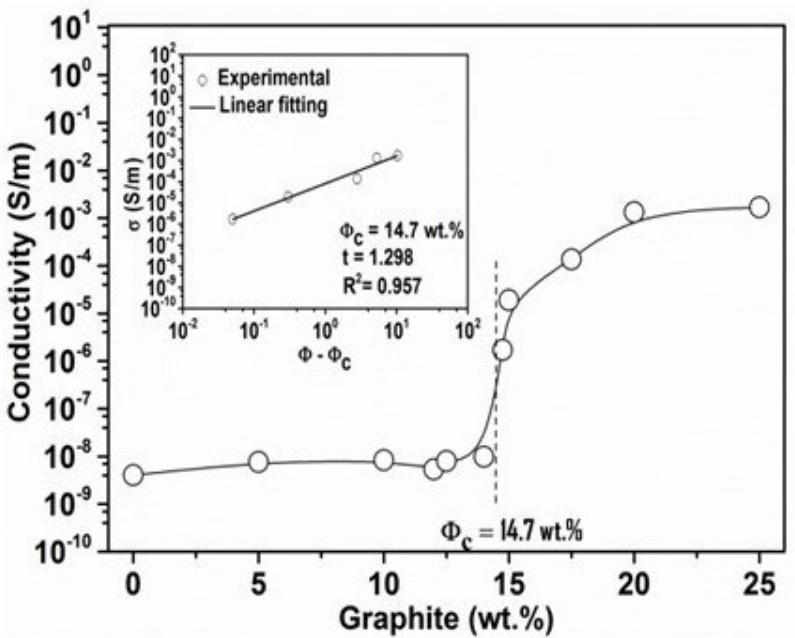
Figure 3. Percolation threshold ( Φ c ) determination plot. Electrical conductivity of PET/graphite micro-composites as a function of graphite content. The inset plot is log σ versus log ( Φ − Φ c )